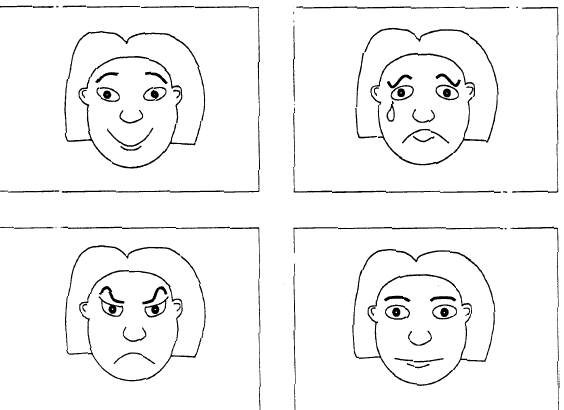
Figura 1 . Primeira prancha para reconhecimento de emoções básicas constituinte do componente do TEC (Pons &Harris,